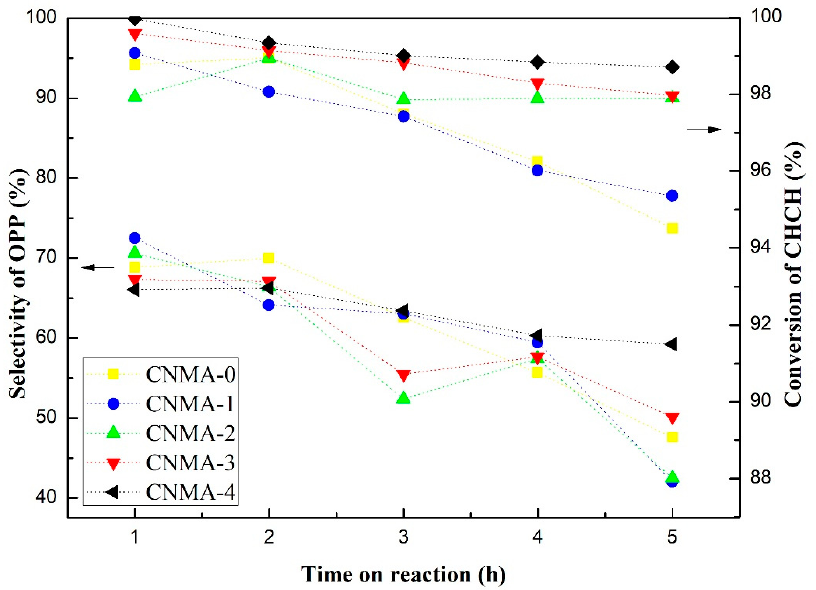
Figure 8. The stability of catalysts with different Ni content at 330 °C. (OPP: O-phenylphenol, CHCH: 2-(1-cyclohexenyl) cyclohexanone).